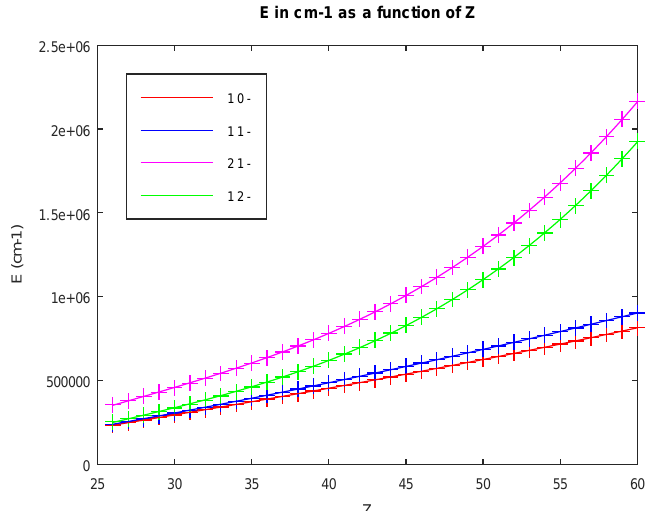
Figure 10. Polynomial fitted to the energies of the 1 0 -, 1 1 -, 2 1 -, and 1 2 - states. The m-file was edited, and we added the legend, see Section